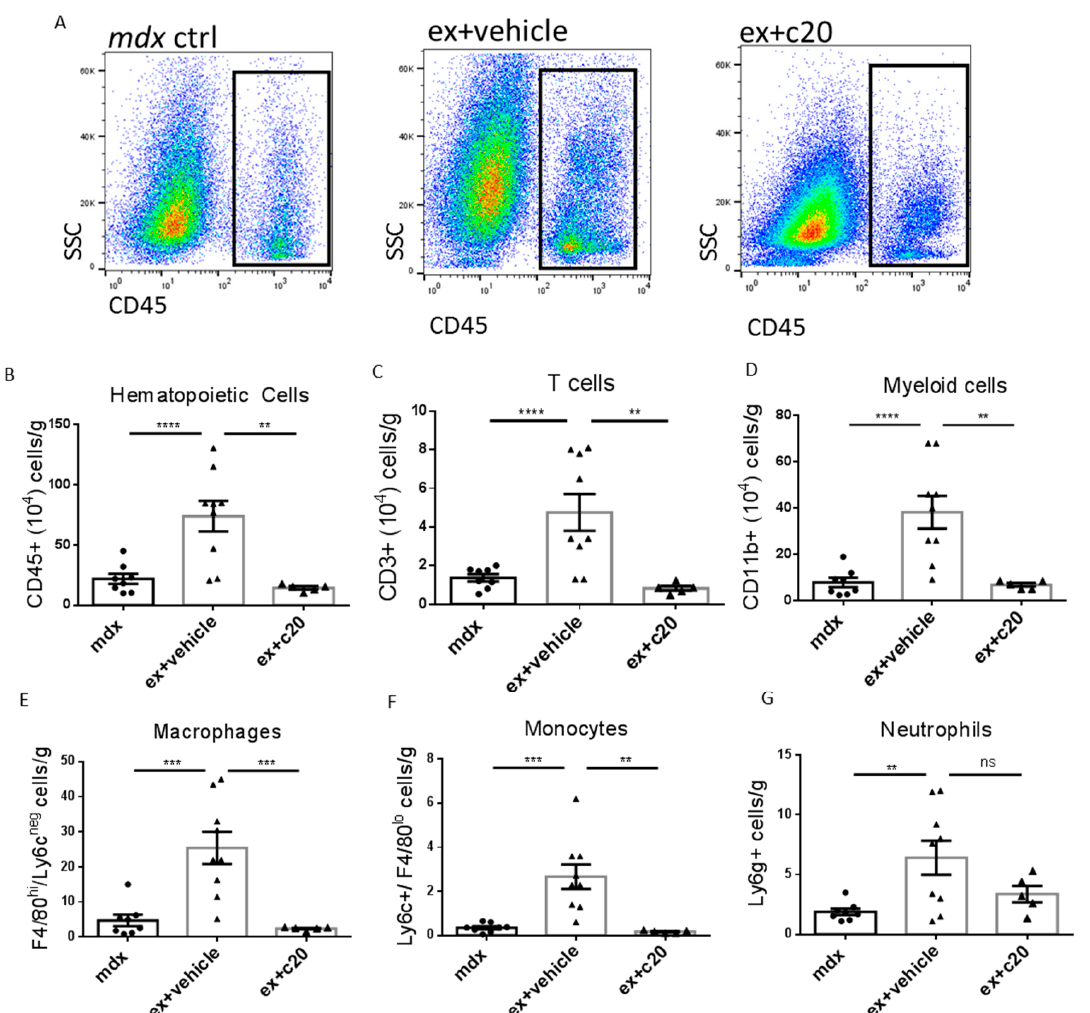
Figure 2. Reduced immune infiltration in C20-treated exercised mdx hearts compared with controls. ( A ) Representative images showing the gating for CD45 + heart immune infiltrating cells in control mdx , vehicle-treated, and C20-treated exercised mdx . ( B – G ) Quantification of total CD45 + cells ( B ) CD3 + T cells ( C ), CD11b + myeloid cells ( D ), F4/80 hi macrophages ( E ), Ly6c hi -F4/80 − inflammatory monocytes ( F ), and Ly6g + neutrophils ( G ) in control mdx , vehicle-treated, and C20-treated exercised mdx hearts, expressed as number of cells normalised per gram of tissue. Data are shown as media +/ − S.E.M. n = 5–9 independent samples per group ** p < 0.01, *** p < 0.001, **** p < 0.0001, ordinary one-way ANOVA with Bonferroni correction for multiple comparisons.